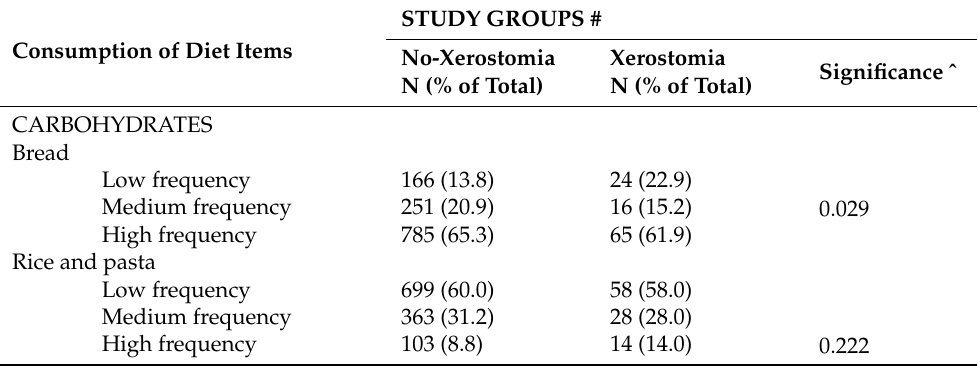
Table 3. Comparison of consumption of selected diet items between the participants stratified by the absence/presence of